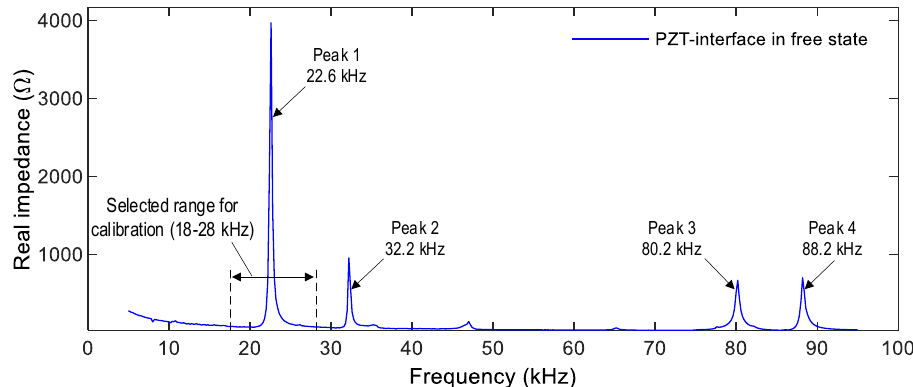
Figure 11. Impedance signal of PZT interface device measured by HIOKI-3532.